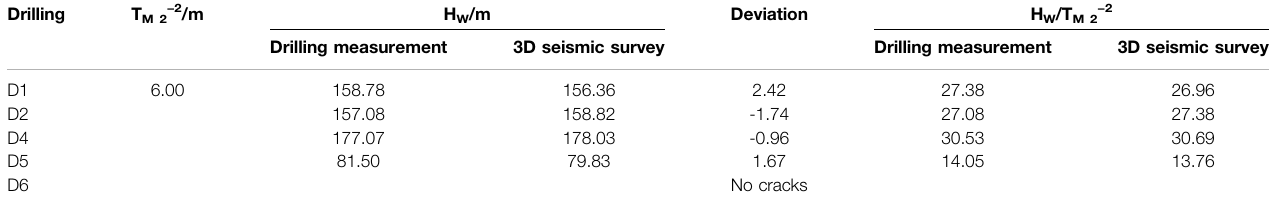
TABLE 3 | WCFZ obtained by different methods. Drilling